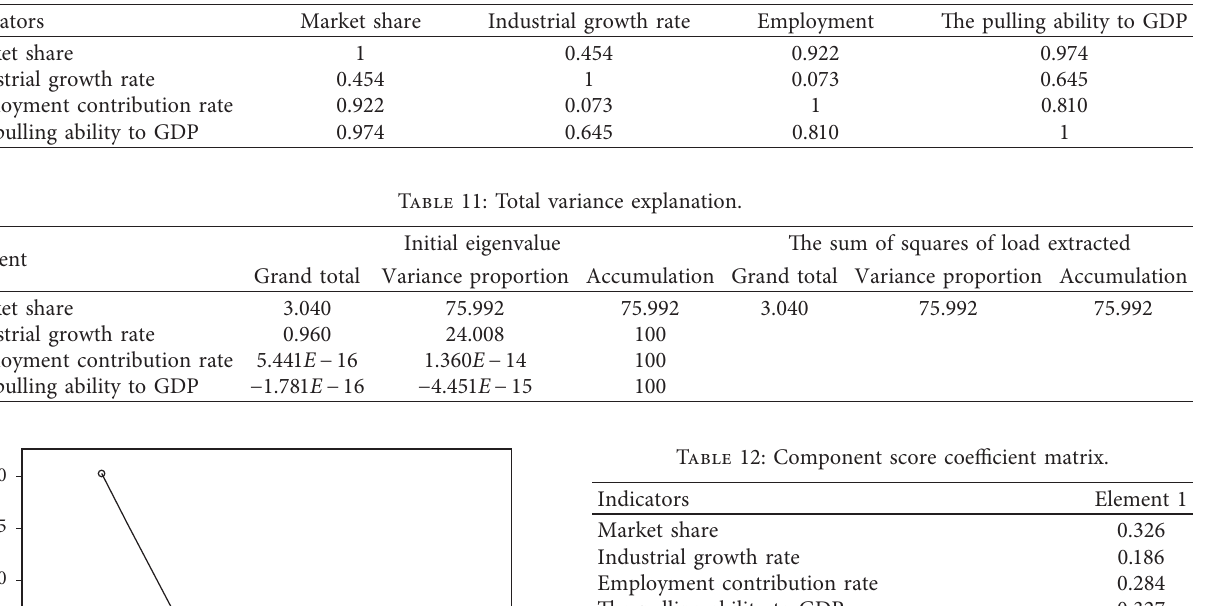
Table 10: Correlation matrix for indicators.